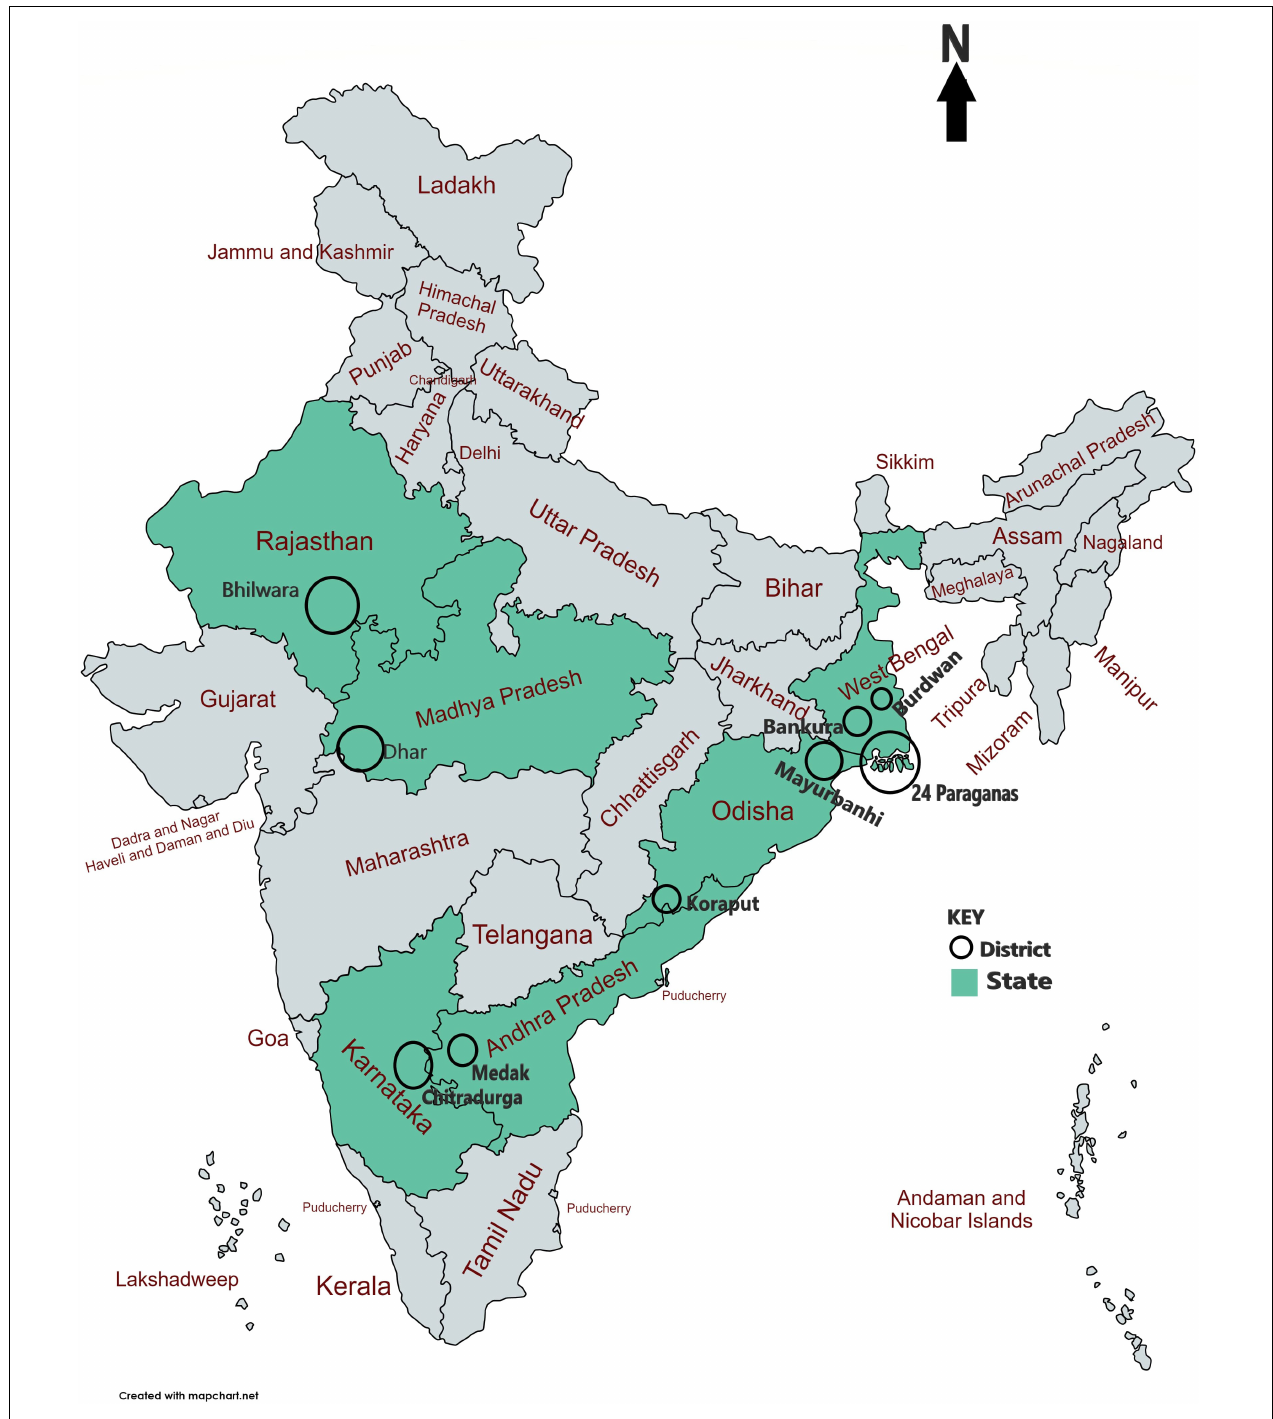
FIGURE 1 | Map of India showing the location of states where afforestation works under MGNREGS in India. Based on encountered